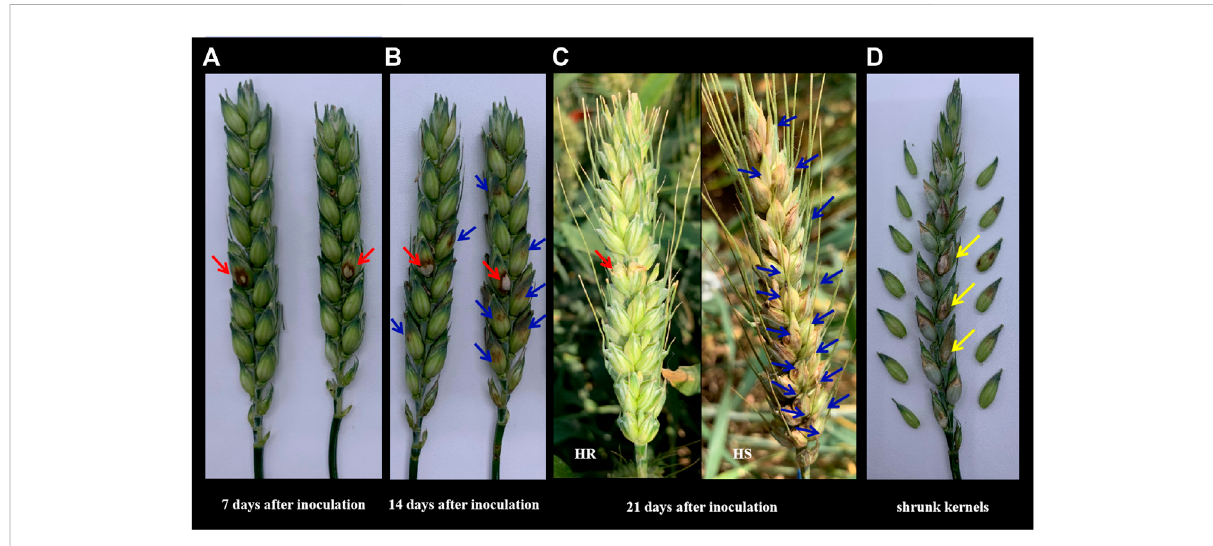
FIGURE 1 The phenotypic symptoms to F.v on the spikelet. (A) The response symptom on the inoculation site of two different lines in the population. Photos were taken 7 days after single fl oret inoculation. Red arrows indicated the inoculation site. (B) The expansion symptom of 14 days after inoculation on different lines in the population. Red arrows showed the inoculation site while the blue ones showed the expansion severity in the above and below directions. (C) The expansion symptom of 21 days after inoculation on the lines with the highest resistance (HR) and the lines with the highest susceptible (HS) in this population in the fi elds. Red arrows showed the inoculation site while the blue ones showed the expansion severity in the above and below directions. (D) Shrunk kernels on inoculation and other infected sites.